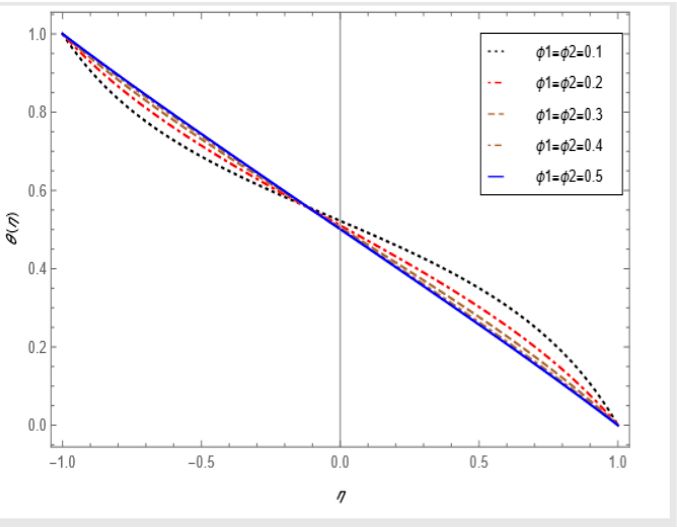
Figure 8: Schmidt number effect on the concentration profile at 𝑎 = 3 , 𝑃𝑟 = 6.2 , = 0.1 .